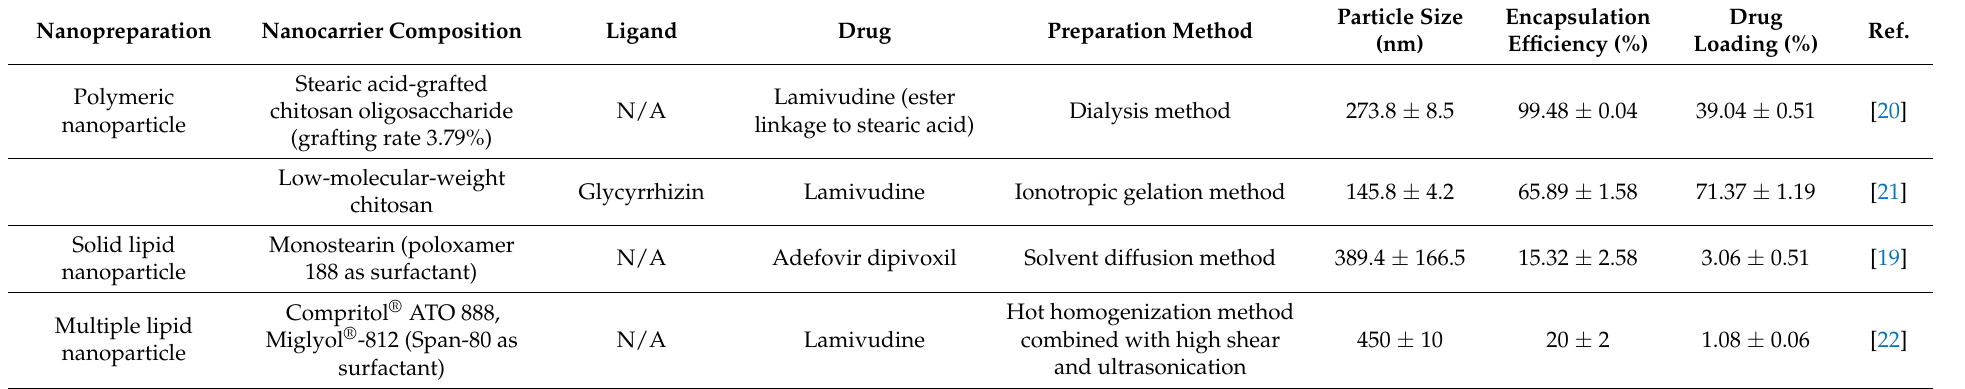
Table 1. Composition and properties of nanoparticle delivery systems for anti-HBV nucleoside